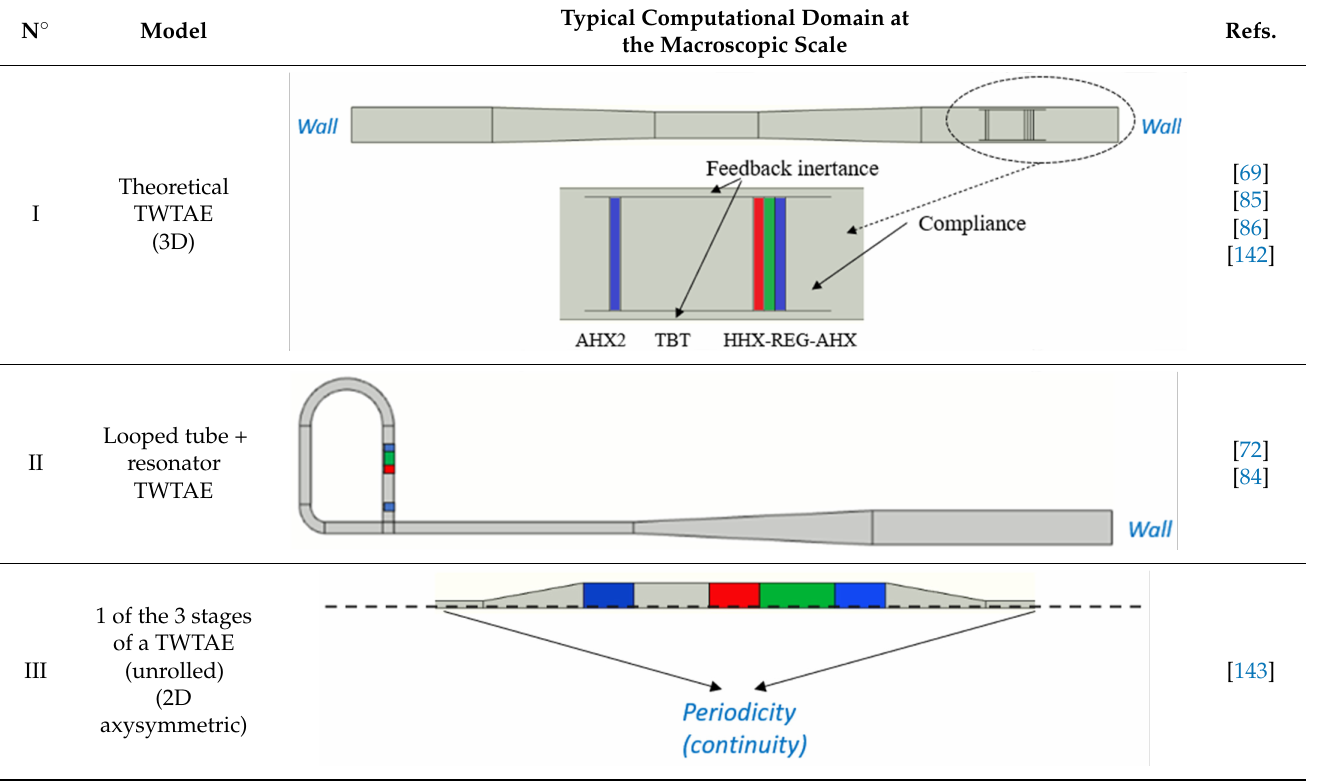
Table 5. Model and computational domain of full device simulations at the macroscopic scale. In the second column, it is specified if the model is 3D or 2D axisymmetric. Typical Computational Domain at the Macroscopic Scale